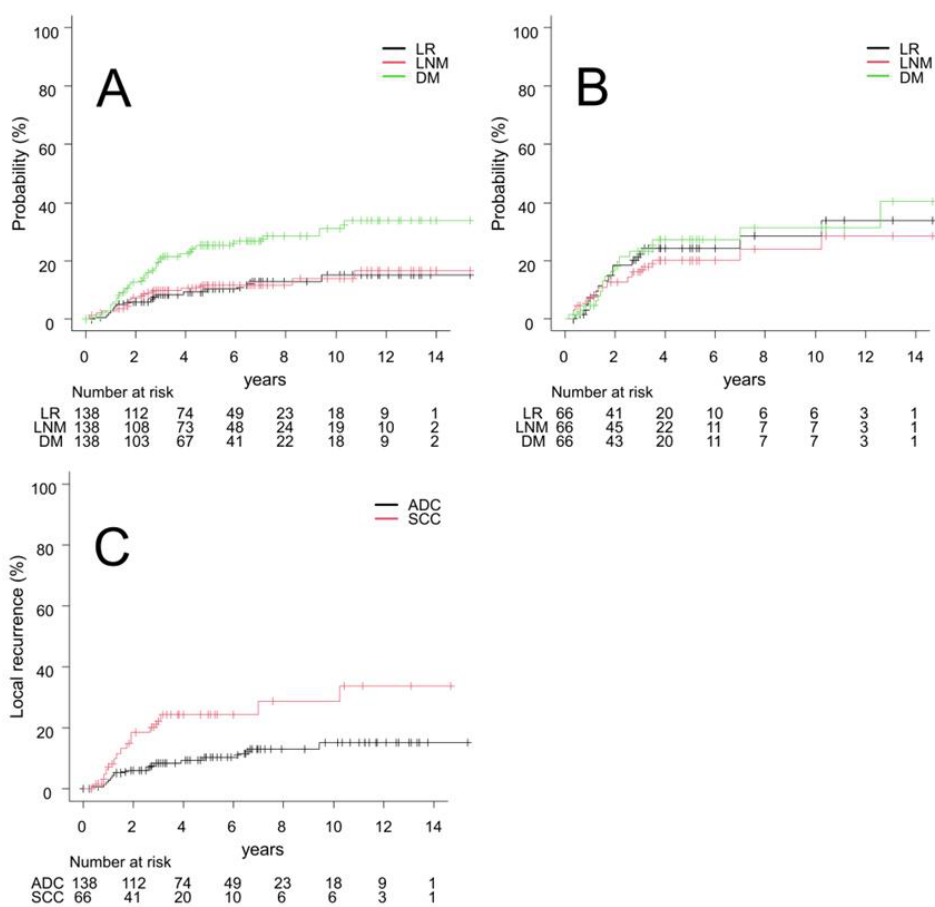
Figure 3. ( A ) Survival curves of local recurrence (LR), lymph node metastasis (LNM), and distant metastasis (DM) in adenocarcinoma (ADC). ( B ) Survival curves of LR, LNM, and DM in squamous cell carcinoma (SCC). ( C ) Comparison of LR curves between ADC and SCC.